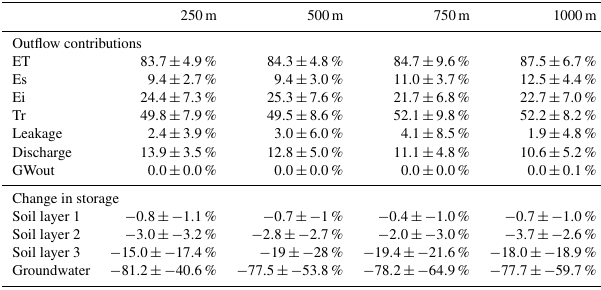
Table 5. Mean catchment outflow contribution over the simulation period (2009–2019), as a proportion of the total catchment outflow, and the percent change of catchment storage from the beginning of 2009 to the end of 2019. Contributions include evapotranspiration (ET), soil evaporation (Es), interception evaporation (Ei), transpi- ration (Tr), leakage, discharge, and groundwater outflow (GWout). Standard deviations of the contributions and storage changes are derived from the 100 best simulations for each